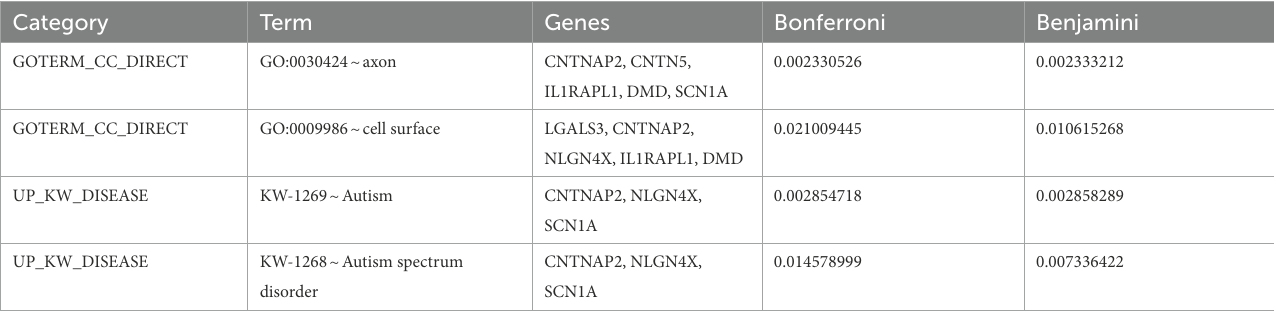
TABLE 2 Enrichment results of genes in a cluster identified by our method in the male infertility data set. Category